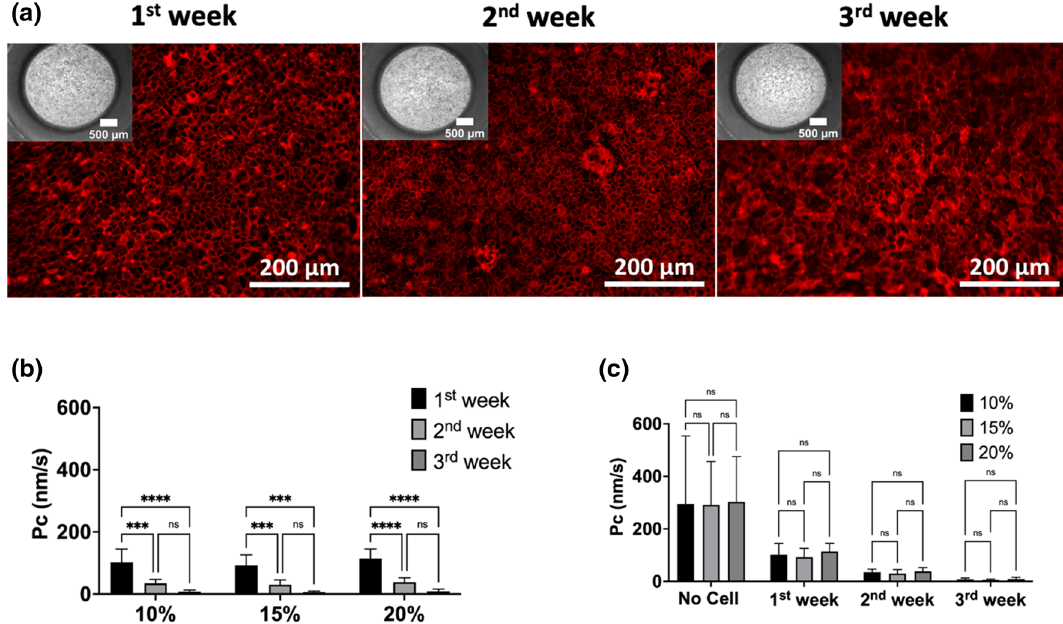
Figure 4. Biological validation of 96-well inserts. ( a ) Growth of Caco-2 cells on the 15% (w/v) gelatin membranes over three weeks. The 10% and 20% cultures had identical morphologies, so only the 15% cultures are displayed. Insert apertures at the bottom are shown at upper panels of fluorescence images (the magnification: 4x; scale bars: 500 µm), and the F-actin (red) stain of the cells on the hydrogel membranes (scale bars: 200 µm; the magnification was 20x). ( b ) Permeability coefficient (mean + SD) of lucifer yellow across Caco-2 cells on the 10%, 15%, 20% (w/v) gelatin membrane assembled inserts (n ≥ 3) and ( c ) comparison of Pc values of empty hydrogel, 10%, 15%, 20% membrane assembled inserts (n ≥ 5). Error bars indicate mean S.D. statistical significance: ns = P > 0.05, ****P < 0.001, ****P <